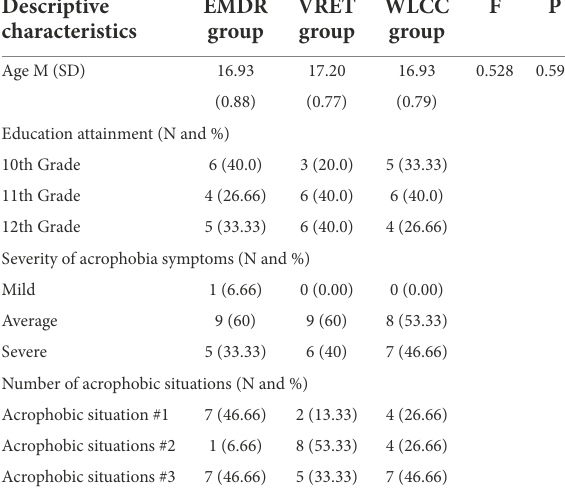
TABLE 1 Demographic characteristics of the randomized controlled trial sample.